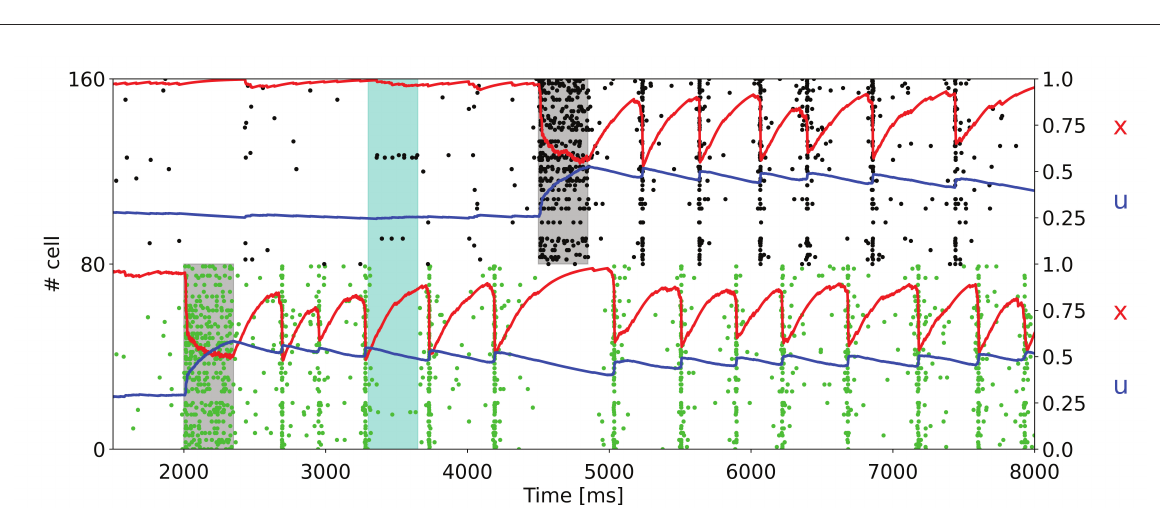
and Mi et al. (2017), the absolute synaptic efficacy is modulated using the values of the variables u and x immediately before the emission of the spikes. As described in Equation (6), the implementation used in this work considers the value of the